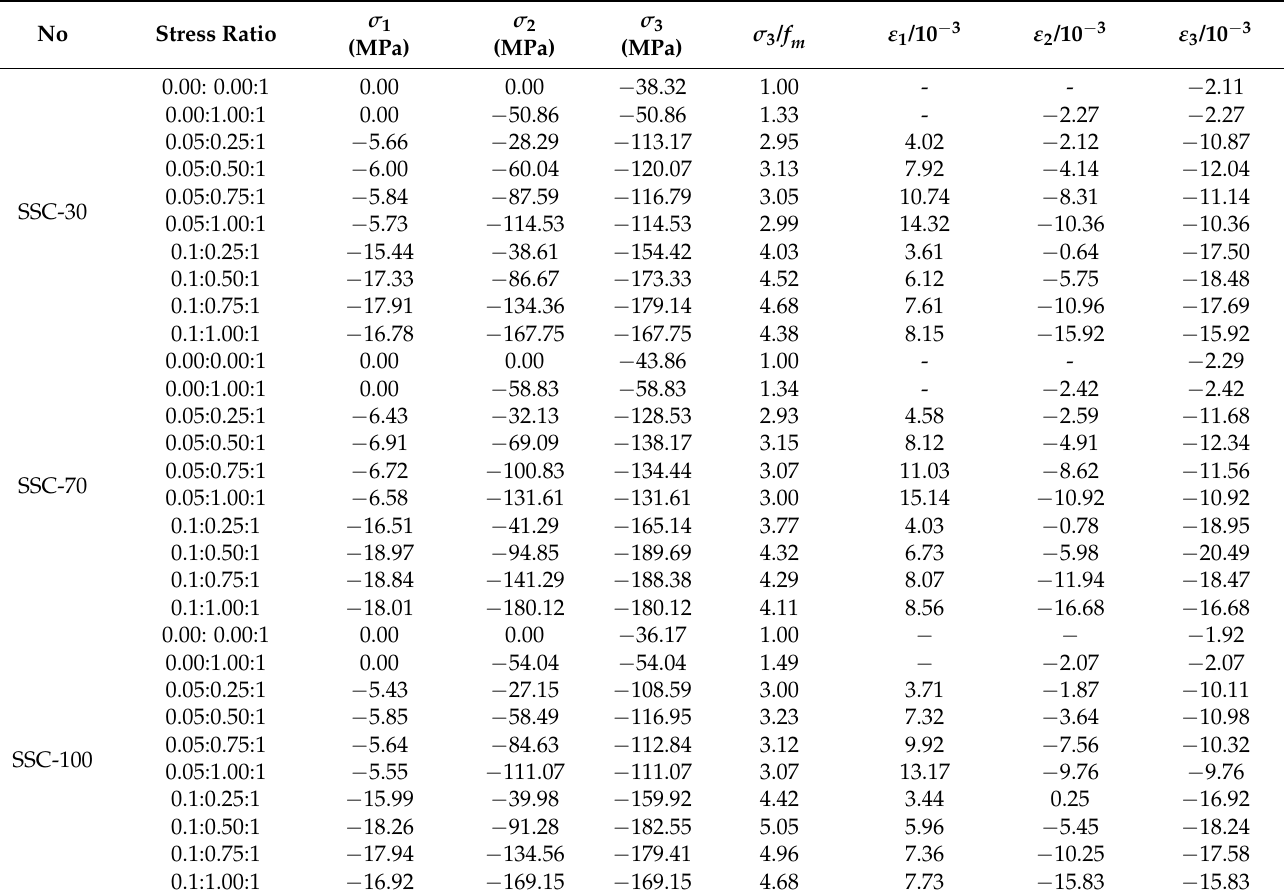
Table 3. Test results of SSC under triaxial